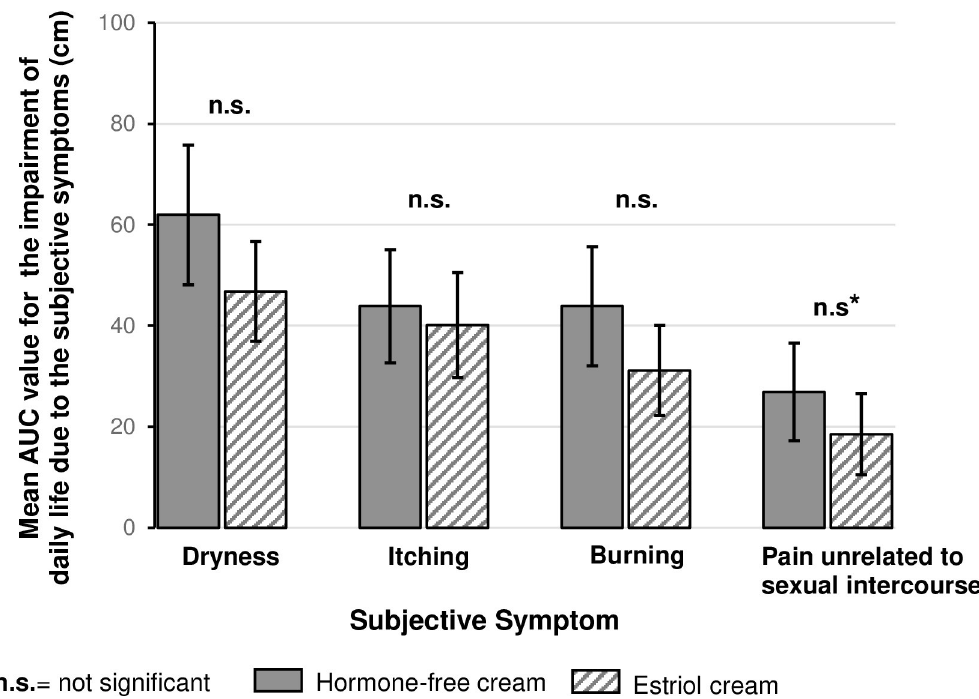
Fig 6. Comparison of the impairment of daily life due to each of the subjective symptoms (AUC). Values represent Mean ± 95% CI. Not significant (n.s.). � Due to different baseline values, an ANCOVA using the baseline value as covariate was performed. The result demonstrated no significant difference at Day 43 between